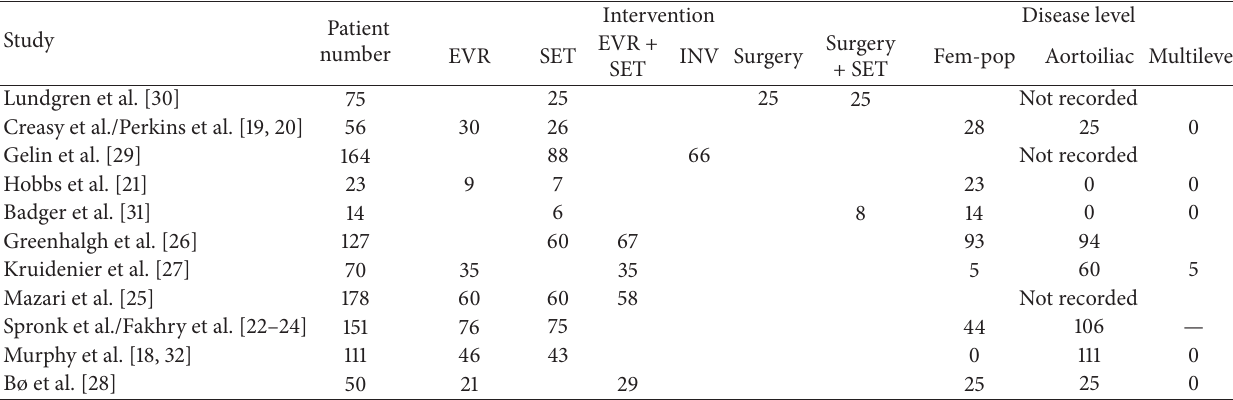
Table 1: Treatment groups and disease